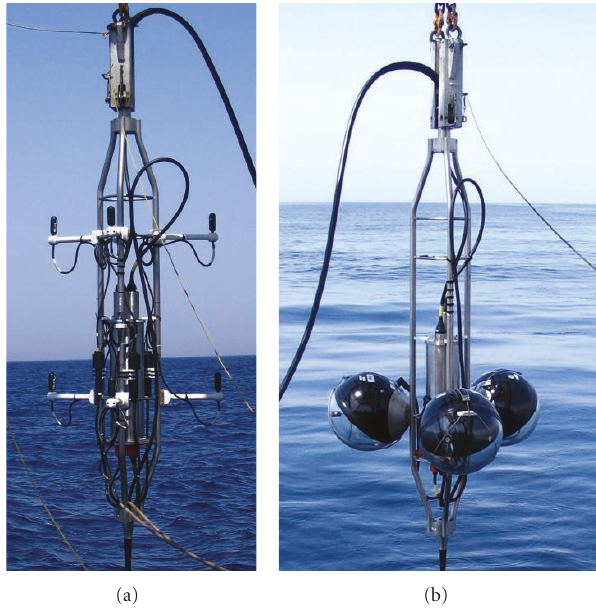
Figure 3: An Acoustic Storey of the IL (a), equipped with hydrophones, and the lower most Acoustic Storey of L12 (b) equipped with Acoustic Modules, shown during their deployment.